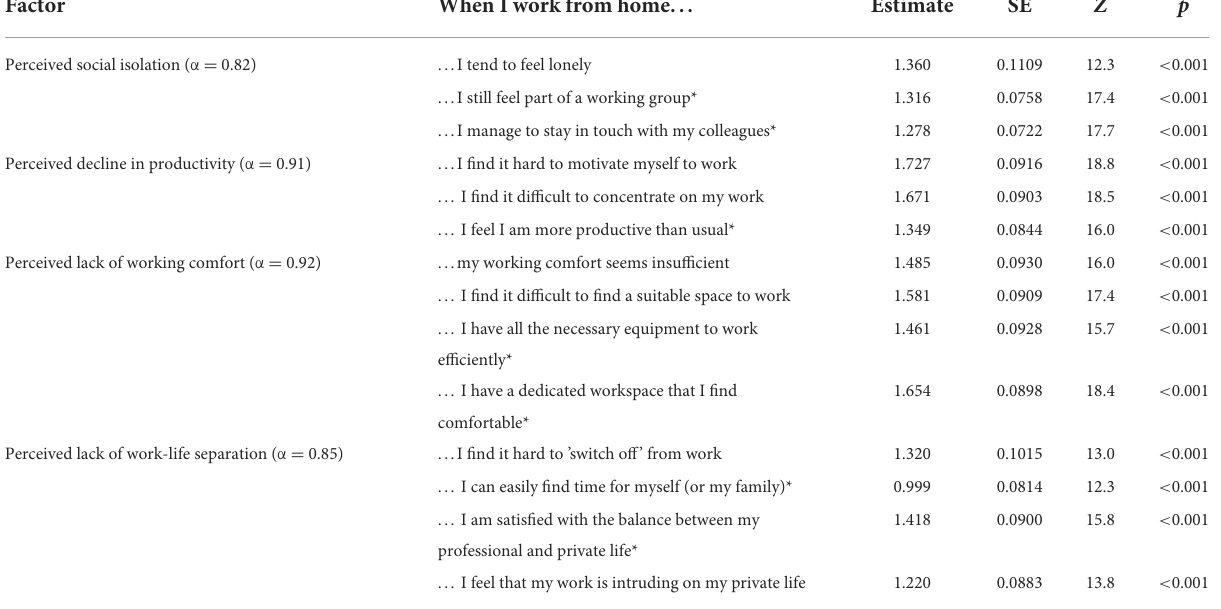
TABLE 2 Dimensions and corresponding items of the teleworking satisfaction questionnaire. Factor When I work from